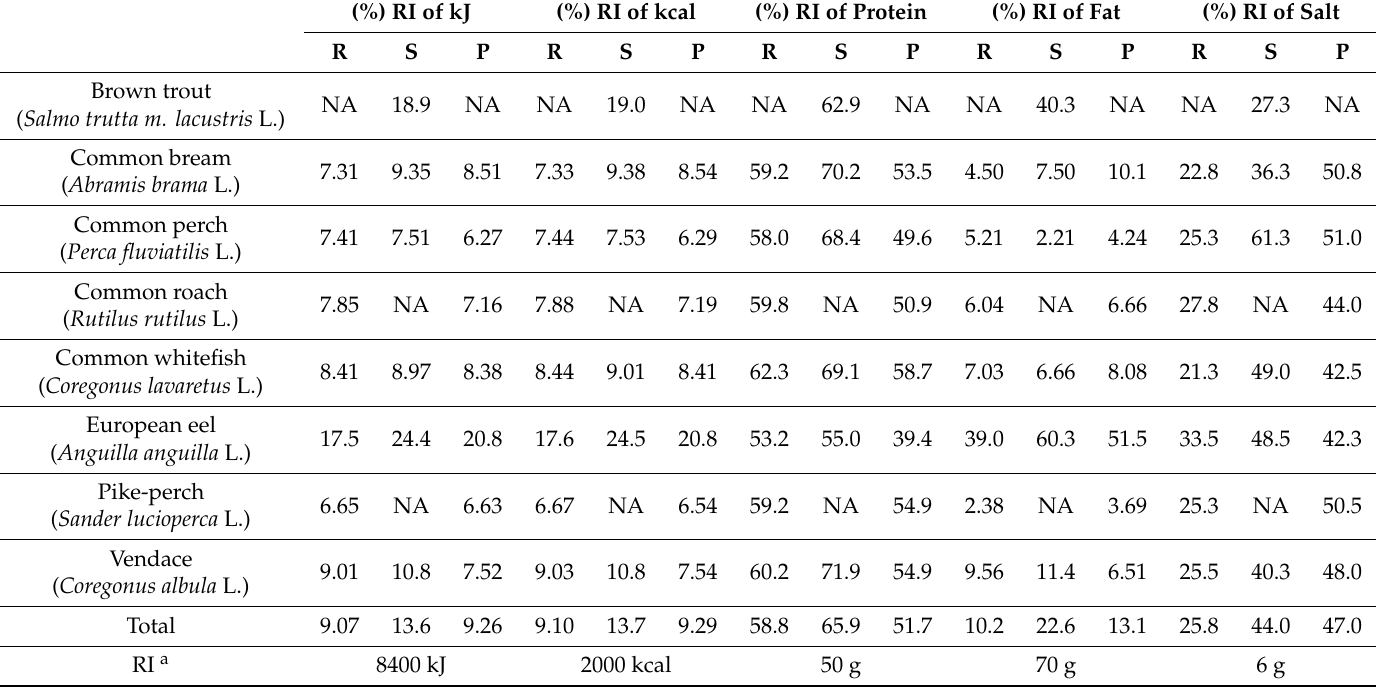
Table 7. Nutrient value provided by 150 g of freshwater fish